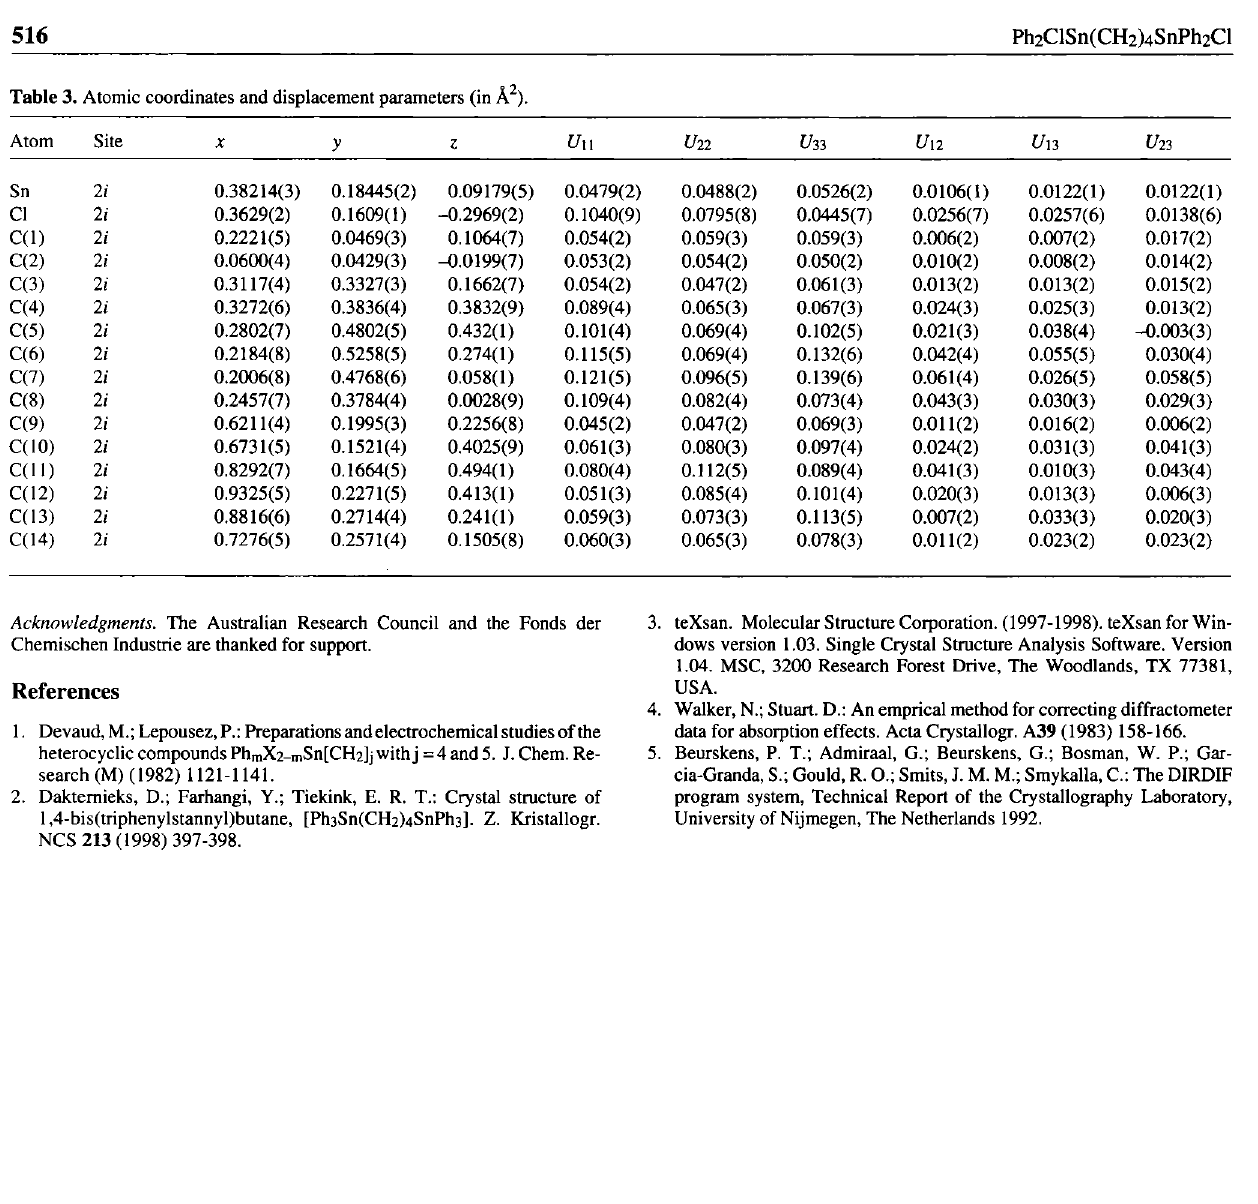
Table 3. Atomic coordinates and displacement parameters (in Ä 2